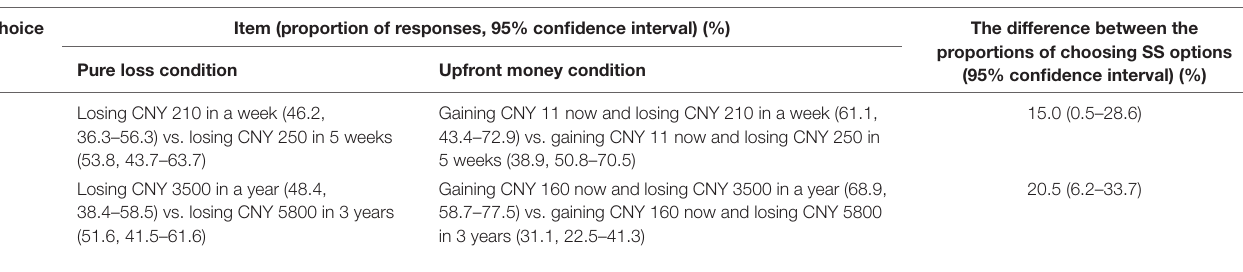
TABLE 1 | Questionnaire items and summary of the choice results for Experiment 1. Choice Item (proportion of responses, 95% confidence interval)